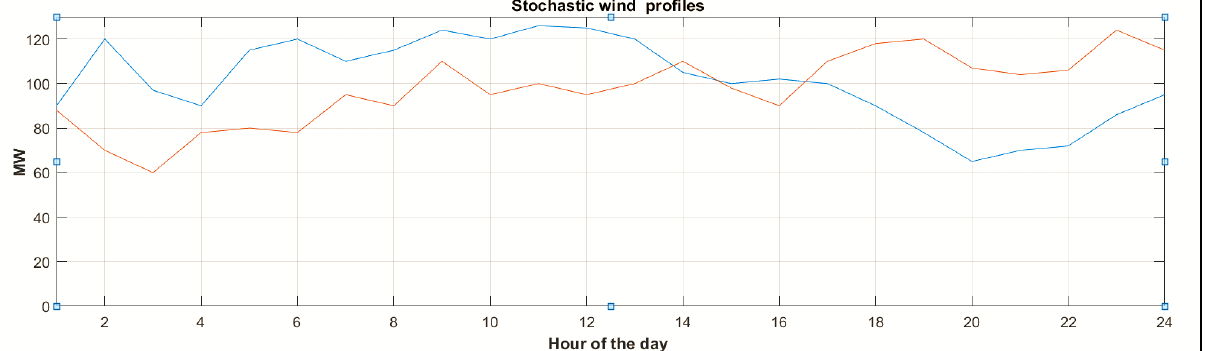
Figure 8. Stochastic wind power generation: two wind scenarios considered for analysis.